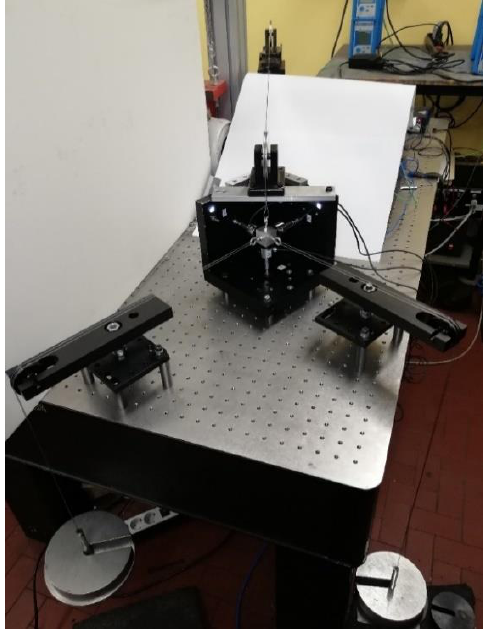
Figure 6. Simultaneous application of static loads in three orthogonal directions.